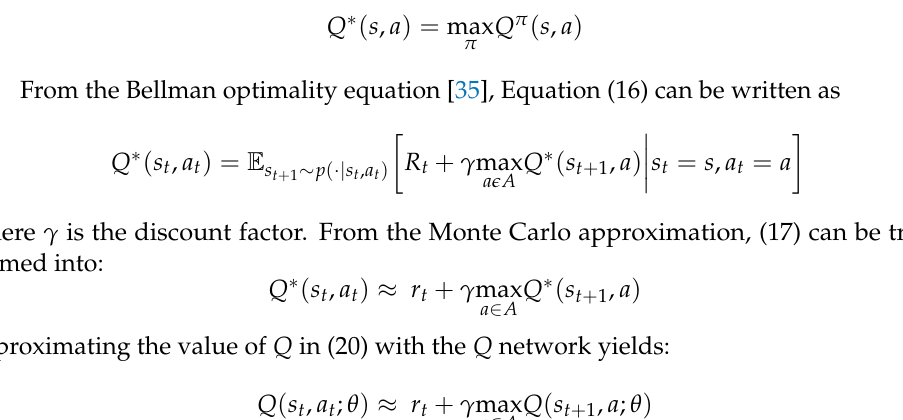
Figure 4. Calculating the Q value for agent n.